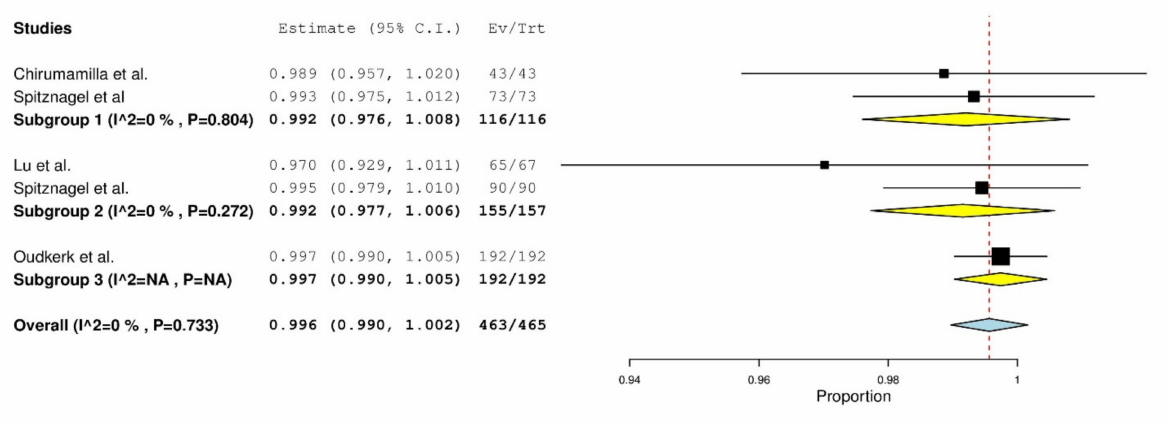
Figure 2. One-year survival forest plot for PICN.